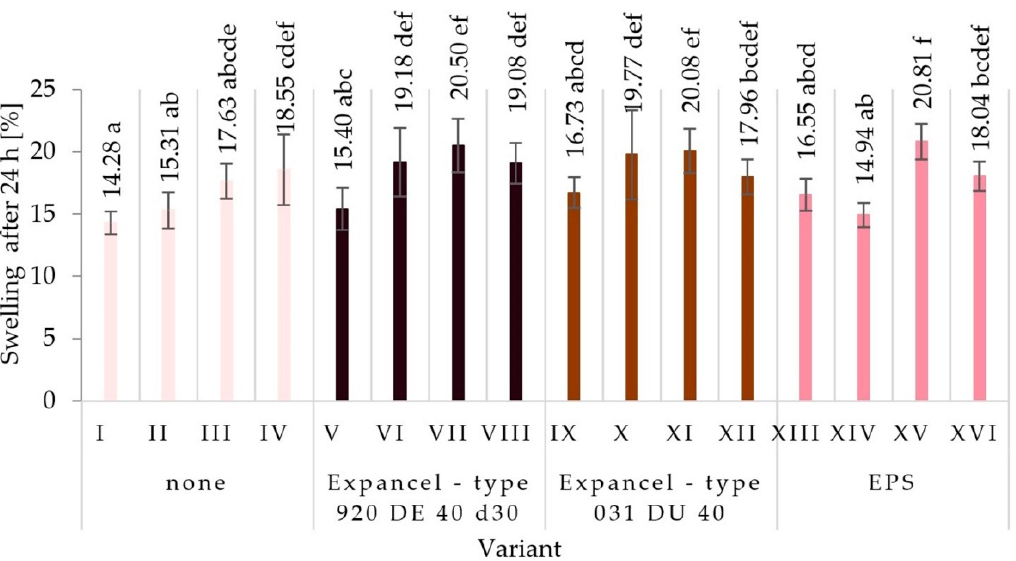
Figure 9. Swelling thickness changes of the produced particleboards after 24 h in water (means and standard deviation, a, b, c, (…). Homogeneous groups were determined by the Tukey test; different letters denote a significant difference; means followed by the same letter do not statistically differ from each other).